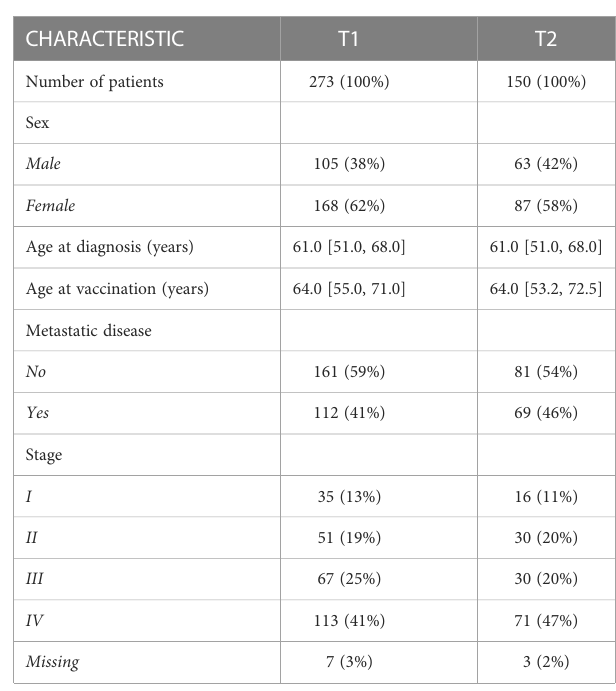
TABLE 1 Demographic and clinical characteristics of patients at different time